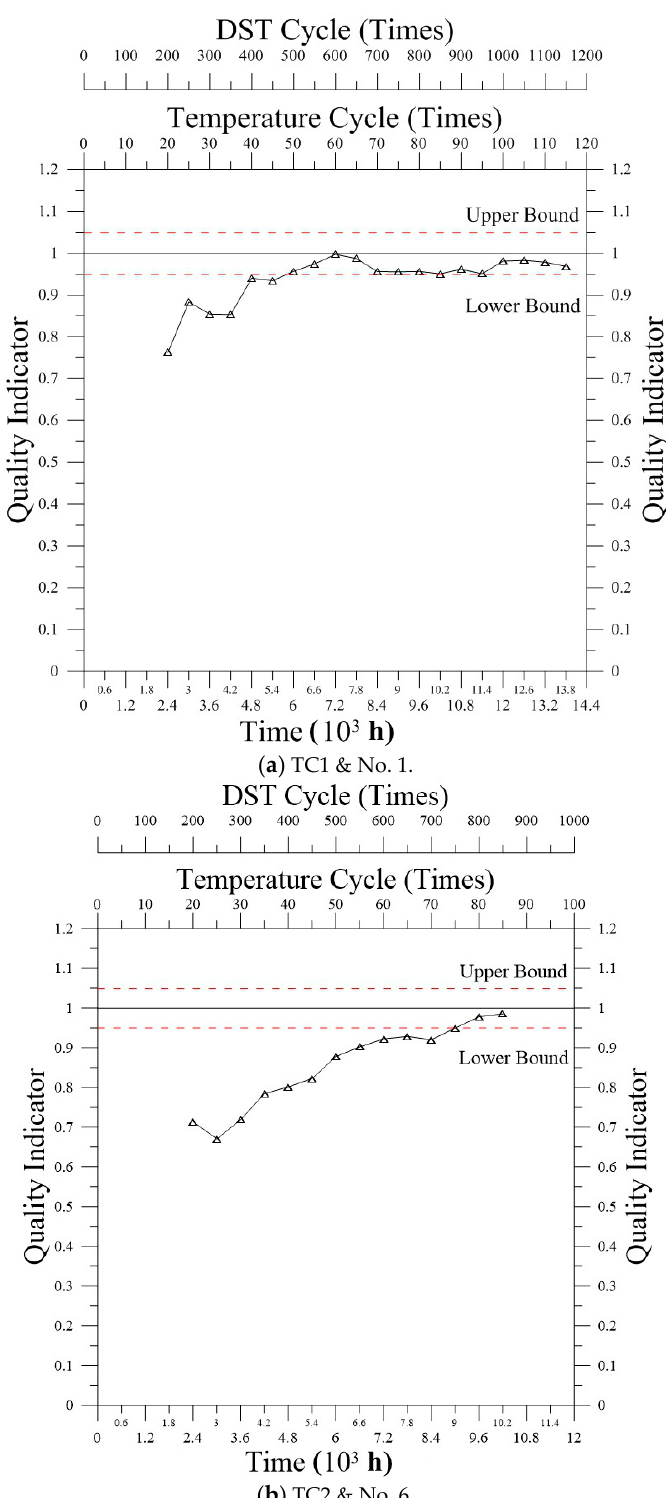
Figure 10. Prognosis quality evaluation of two test batteries in different temperature cycles.